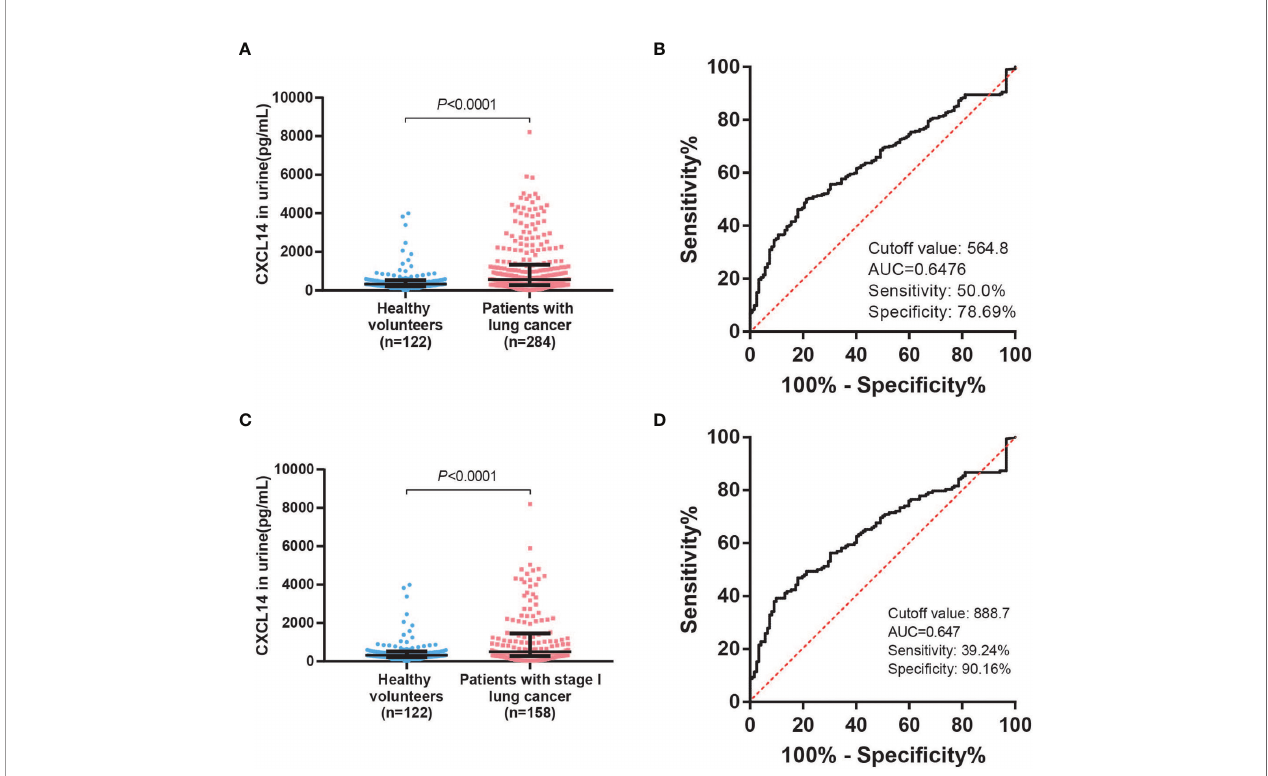
FIGURE 3 | Urinary CXCL14 as a diagnostic biomarker in distinguishing lung cancer patients from control subjects. (A) Comparison of the CXCL14 concentration (determined by ELISA) in urine between control subjects (n=122) and lung cancer patients (n=284) in a retrospective cohort. P <0.0001 determined by Mann – Whitney U tests. (B) ROC analysis of the diagnostic ef fi ciency of urinary CXCL14 in a retrospective cohort of control subjects versus lung cancer patients (AUC=0.6476, 95% CI: 0.5934 – 0.7091, P <0.0001). Scatter diagrams present the median values with interquartile ranges. (C) Comparison of the CXCL14 concentration (determined by ELISA) in urine between control subjects (n=122) and stage I lung cancer patients (n=158) in a retrospective cohort. P <0.0001 determined by Mann – Whitney U tests. (D) ROC analysis of the diagnostic ef fi ciency of CXCL14 in control subjects versus stage I lung cancer patients in a retrospective cohort (AUC=0.647, 95% CI: 0.5829 – 0.7111). Scatter diagrams present the median values with interquartile